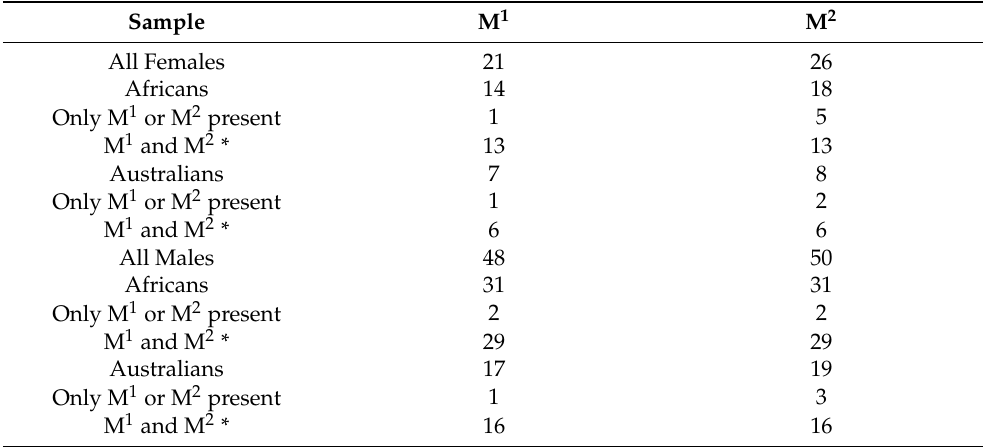
Table 1. The number of upper first (M 1 ) and second (M 2 ) molars examined in this study; * both types of molars were present in the same